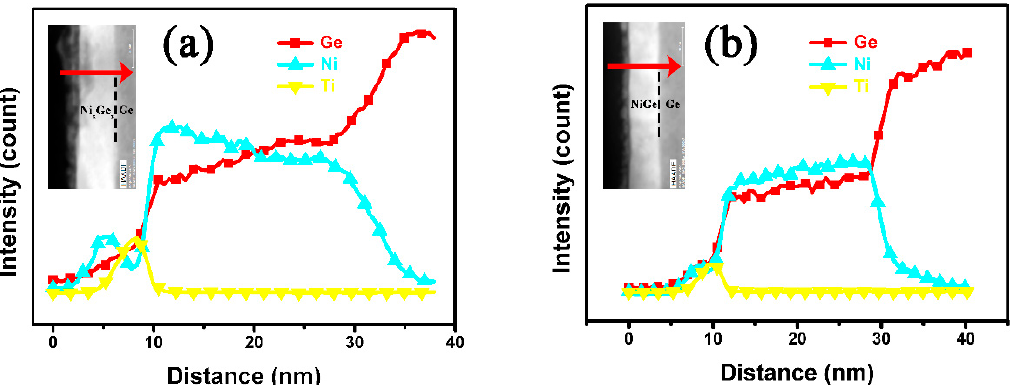
Figure 5. EDS profiles of Ni, Ge, and Ti from the Ni x Ge y layer annealed at ( a ) 250 ◦ C, ( b ) 350 ◦ C. The inset shows the scan direction of the EDS measurements.